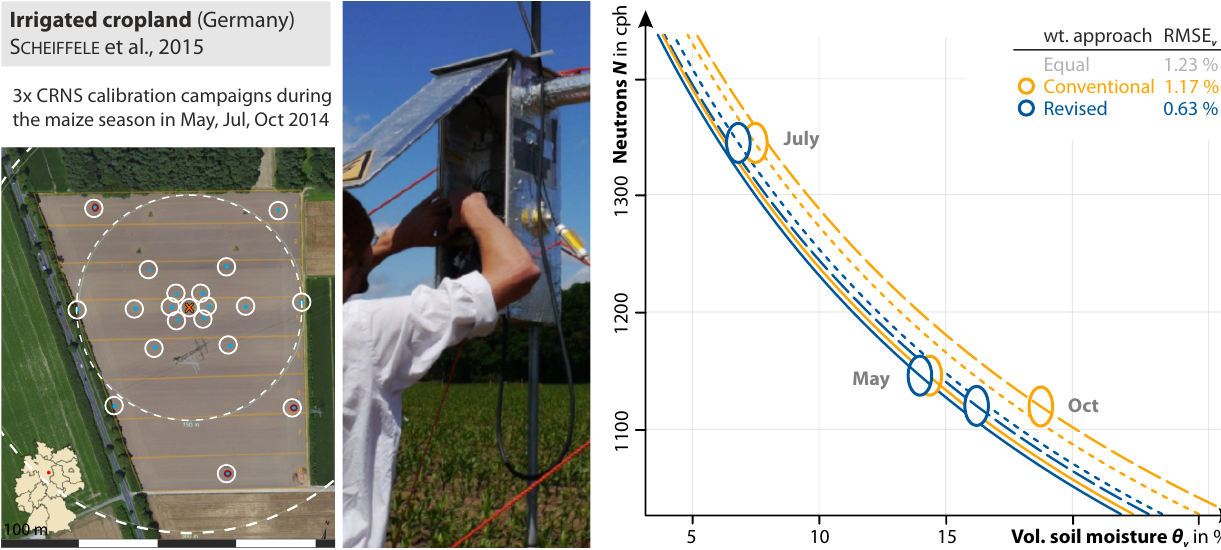
Figure 6. Recalibration of the CRNS sensor in an agricultural maize field (Braunschweig, Germany). Sizes of the circles indicate the corresponding uncertainty range of the measurement, while every such measurement corresponds to a calibration curve θ(N , N 0 ) . The conventional weighting approach is not able to provide a unique theoretical line through the 3 calibration days. Furthermore, for a given neu- tron observation the difference between estimated moisture (lines) and actual soil moisture (ellipses) indicates unrealistic biomass dynamics throughout the study period (see explanations in the text). The revised approach converges the datasets to confirm the accepted neutron theory almost in a single calibration curve within uncertainties (size of